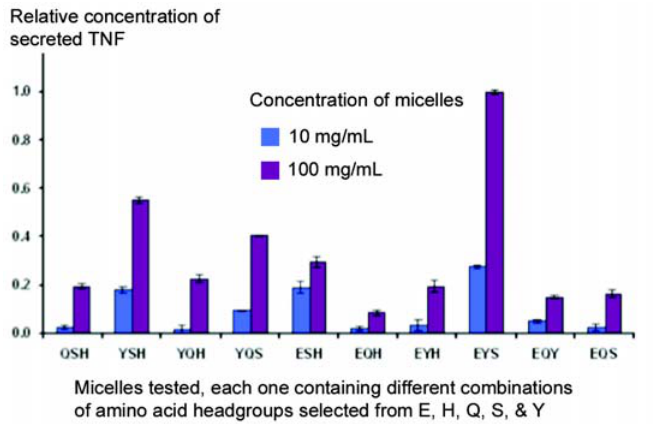
Figure 6. A partial screen carried out to identify micelles capable of stimulating J774A.1 macrophage-derived cells to secrete